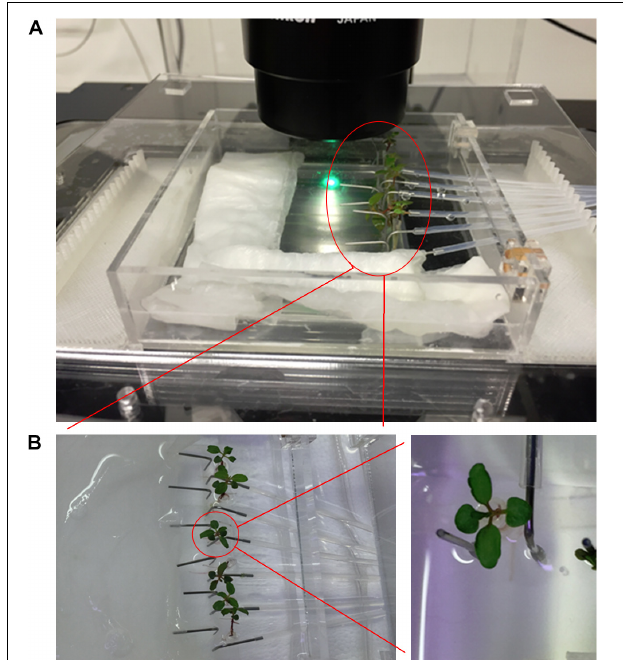
FIGURE 2 | Imaging setup. (A) The imaging setup with humidity chamber and 3D printed stage adaptor. The RMI-chip has an inlet for media, a separate port for inoculation, and a wide channel to accommodate the tree seedling root without interfering with constant media flow. (B) The continuous flow incubation chamber enables the cultivation of six seedlings in parallel (left). Details of an aspen seedling